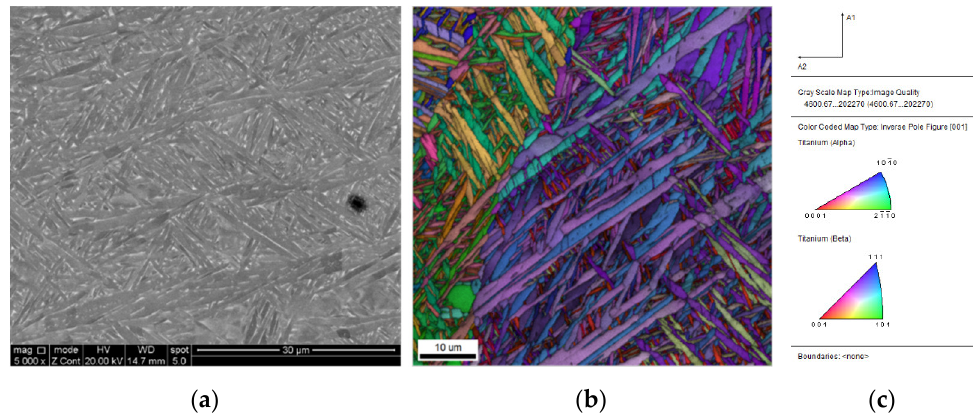
Figure 3. Microstructure observation: ( a ) Secondary electron SEM image; ( b ) EBSD scan color coded according to the inverse pole figure legend shown in ( c ) the details of EBSD observation are reported in Ref. [69].